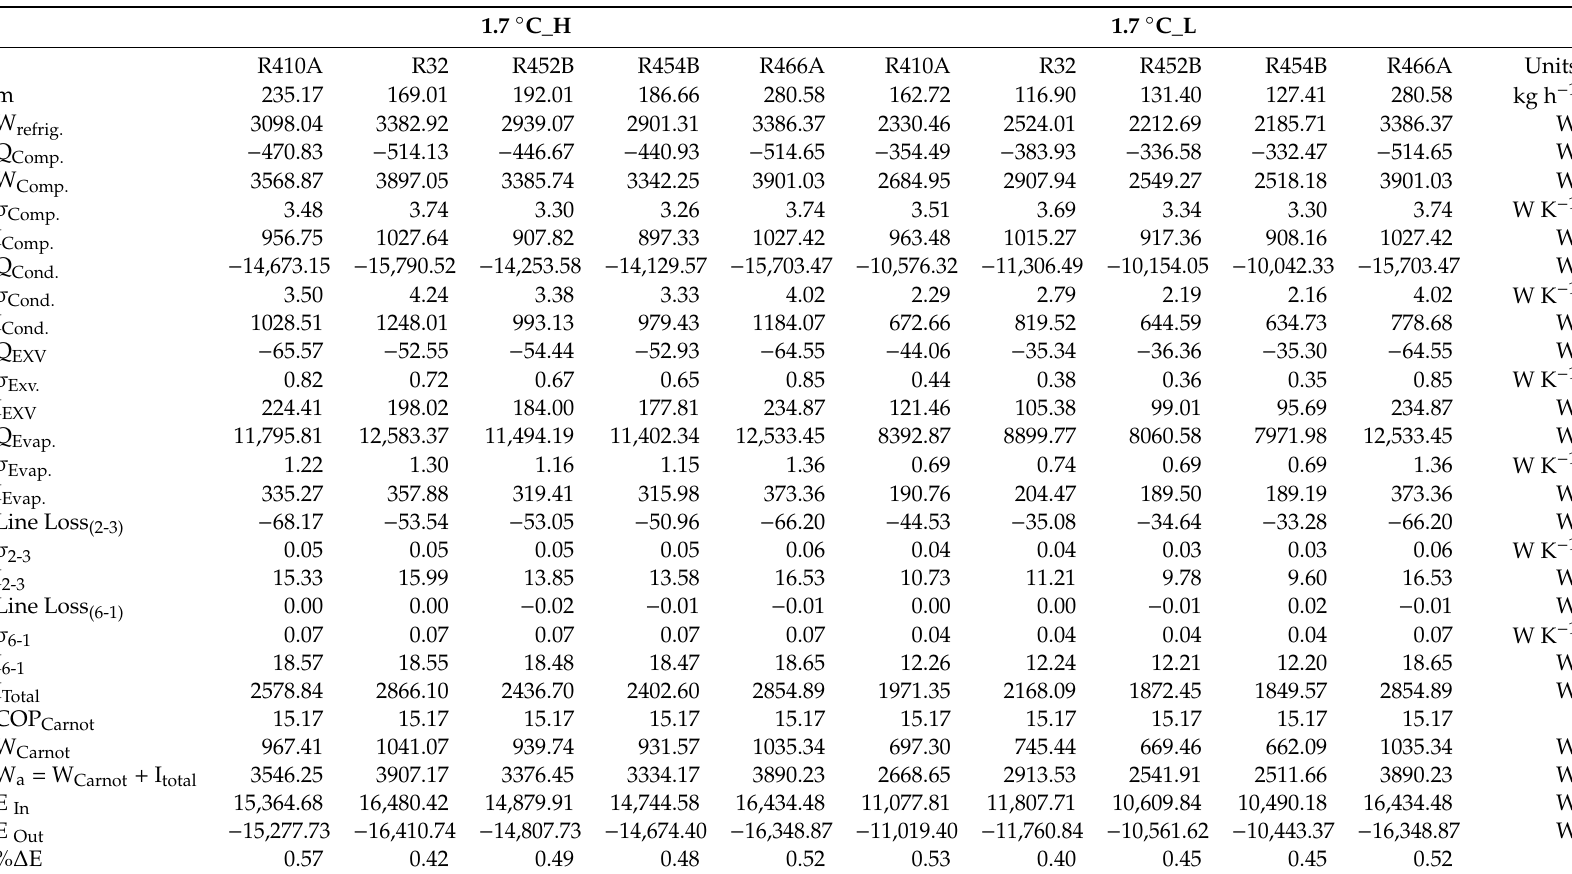
Table 6. Thermal and mechanical energy exchanges from the HPDM model and application of Equations (8)–(11), at 1.7 ◦ C ambient